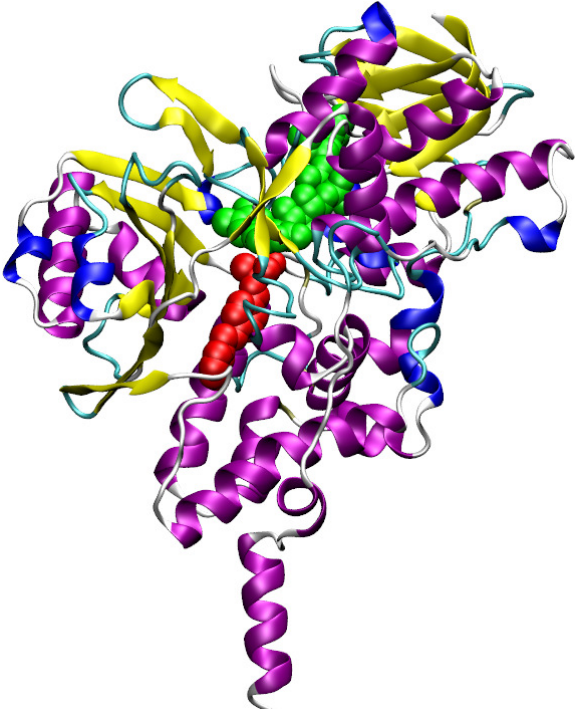
Figure 2. MAO-B safinamide complex as reported in the crystal structure (PDB id is